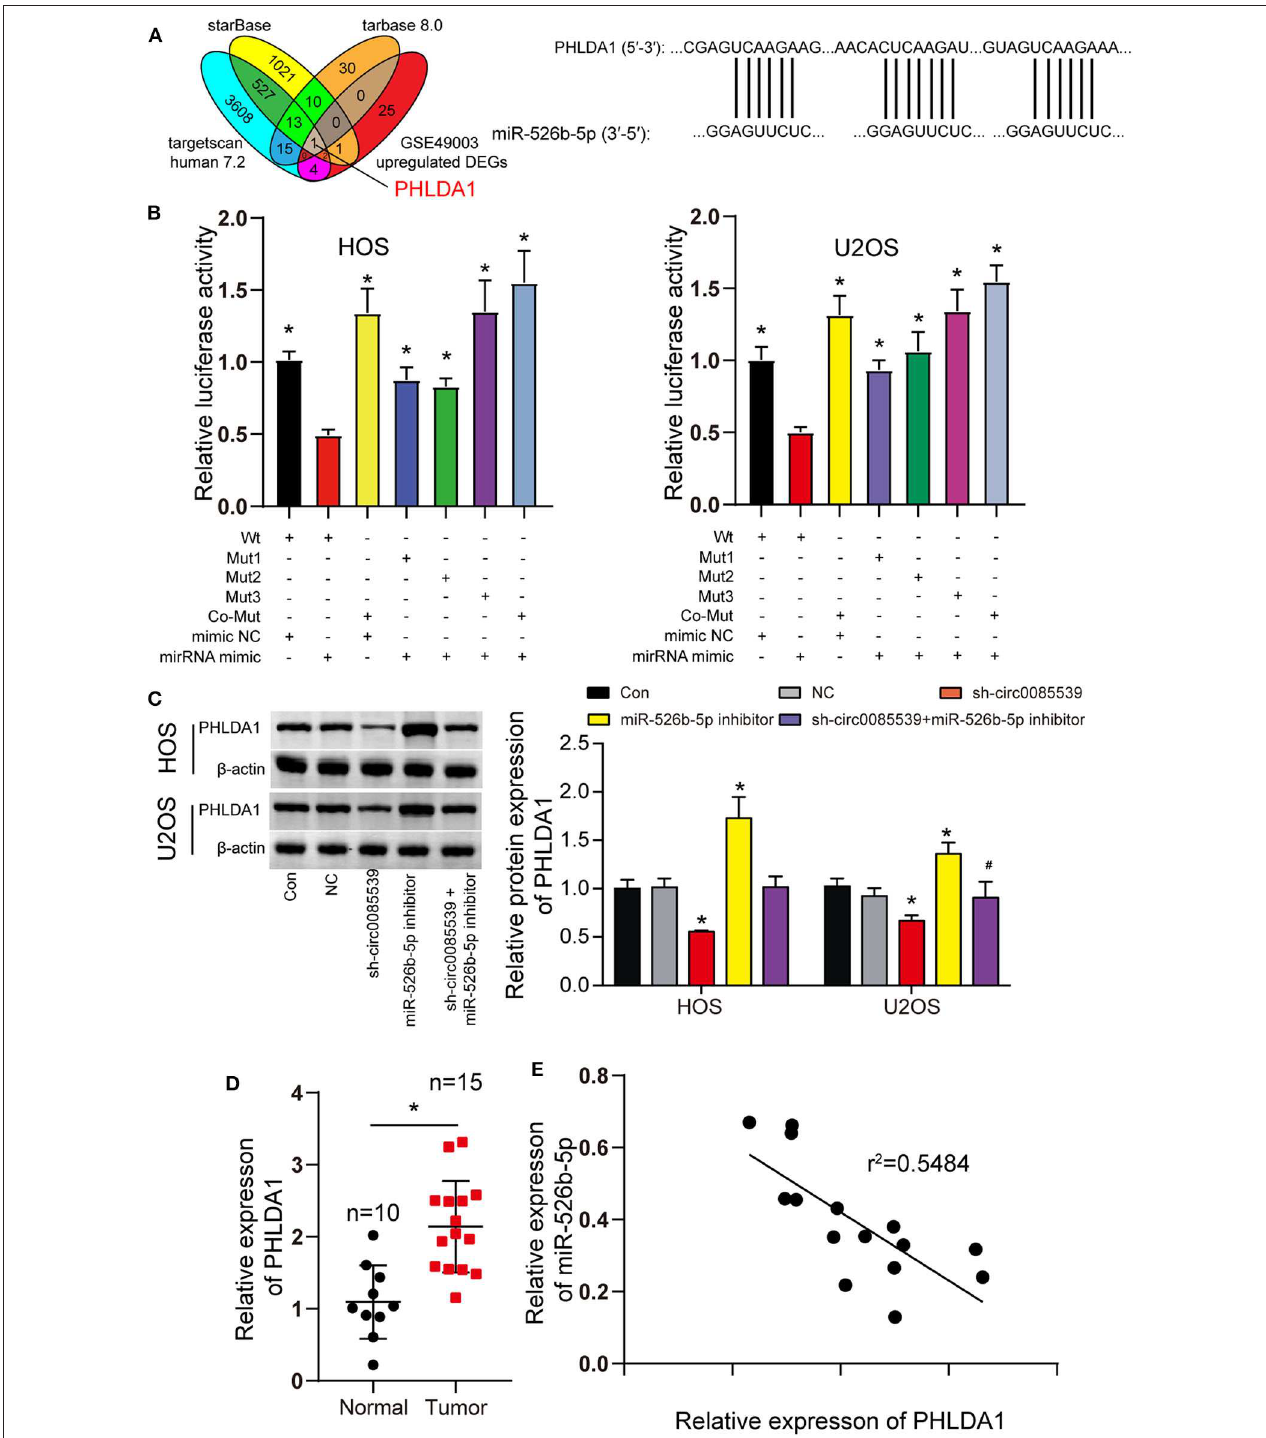
FIGURE 5 | MiR-526b-5p directly targeted pleckstrin homology-like domain family A member 1 (PHLDA1) in osteosarcoma (OS) cells. (A) Potential binding sites between miR-526b-5p and PHLDA1 mRNA 3 ′ untranslated region (UTR). (B) Luciferase reporter assay in OS cells cotransfected with miR-526b-5p mimic and PHLDA1-Wt or PHLDA1-Mut reporter plasmids. * p < 0.05 compared with Wt + mimic group. (C) Protein expression of PHLDA1 was detected by Western blot analysis. * p < 0.05 compared with control group. # p < 0.05 vs. sh-circ0085539 group. (D) Quantitative reverse transcription PCR (qRT-PCR) showed that PHLDA1 expression was significantly upregulated in OS tissues. Normal: adjacent tissues. * p < 0.05 compared with normal group. (E) Correlation analysis showed that miR-526b-5p expression was inversely associated with PHLDA1 expression in OS tissues.